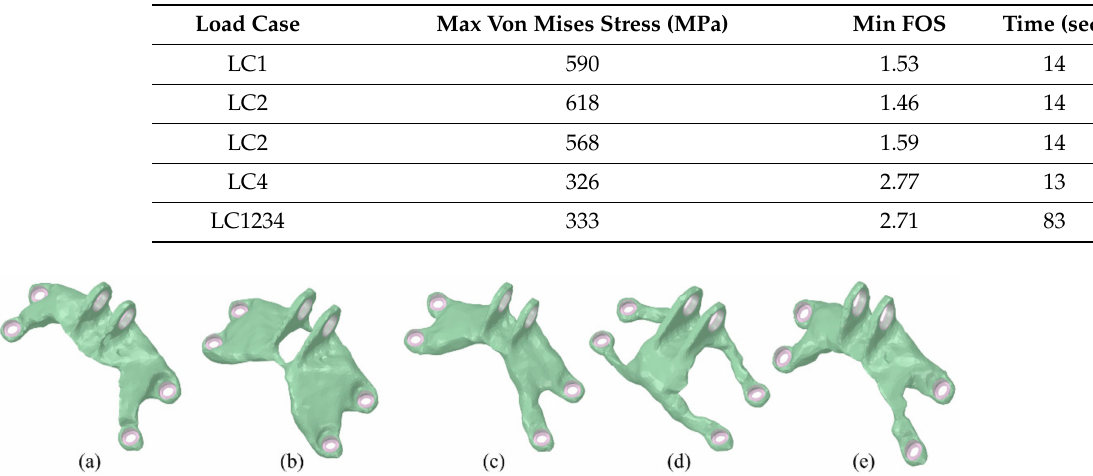
Table 1. The FEA results of the GE bracket.